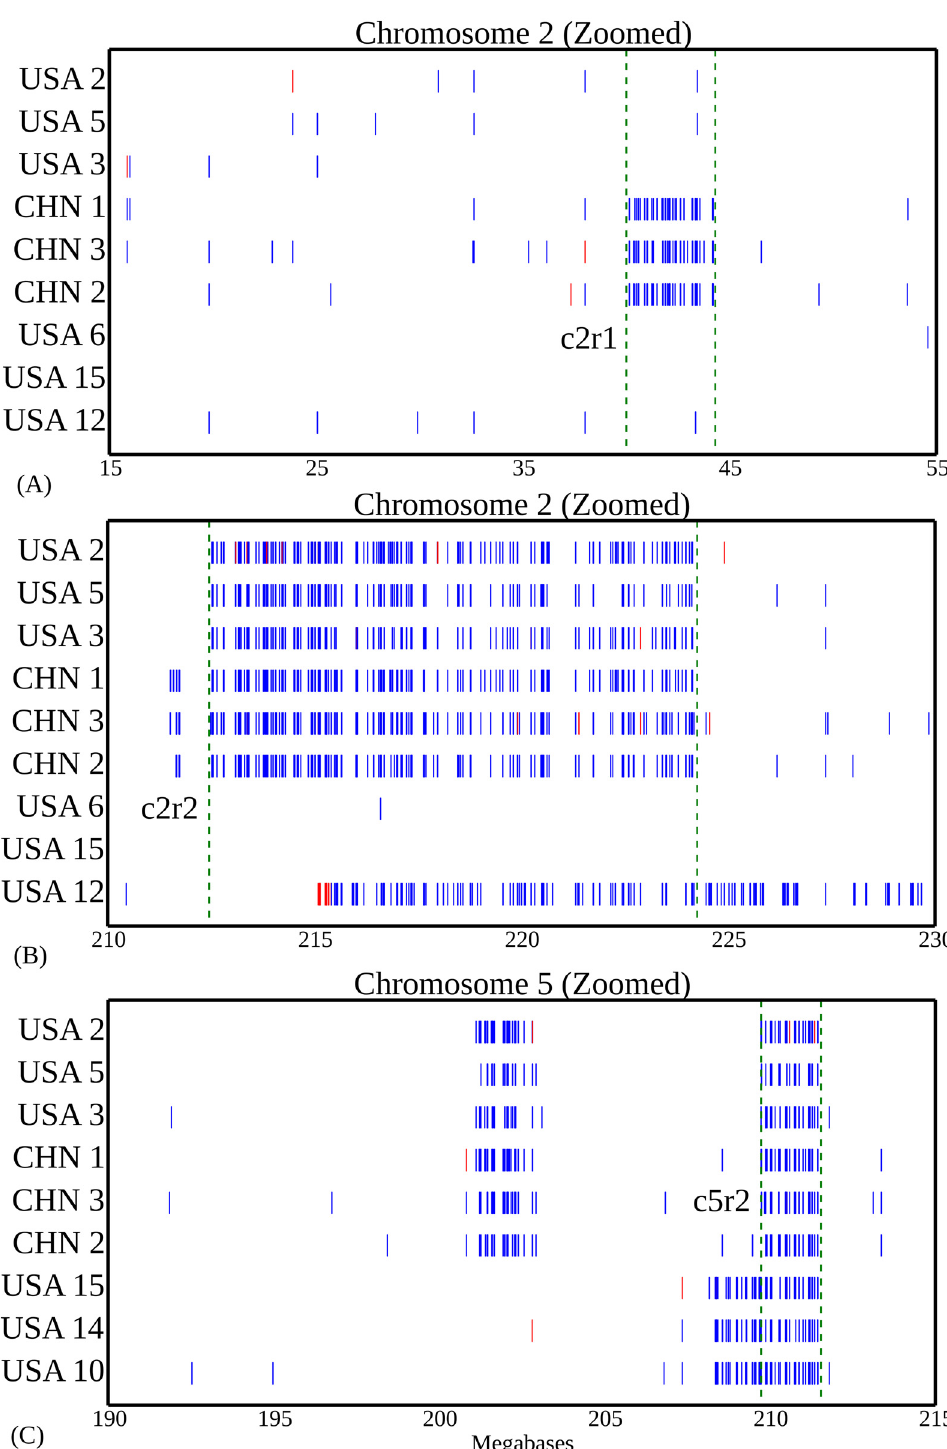
Fig 3. Zoom in on haplotype regions c2r1, c2r2 and c5r2. (A) Haplotype region c2r1 on Chromosome 2; (B) Haplotype region c2r2 on Chromosome 2; (C) Haplotype region c5r2 on Chromosome 5. Non-reference-like homozygous genotypes are indicated in blue and heterozygous genotypes in red. Named haplotype regions are those between the green bars.